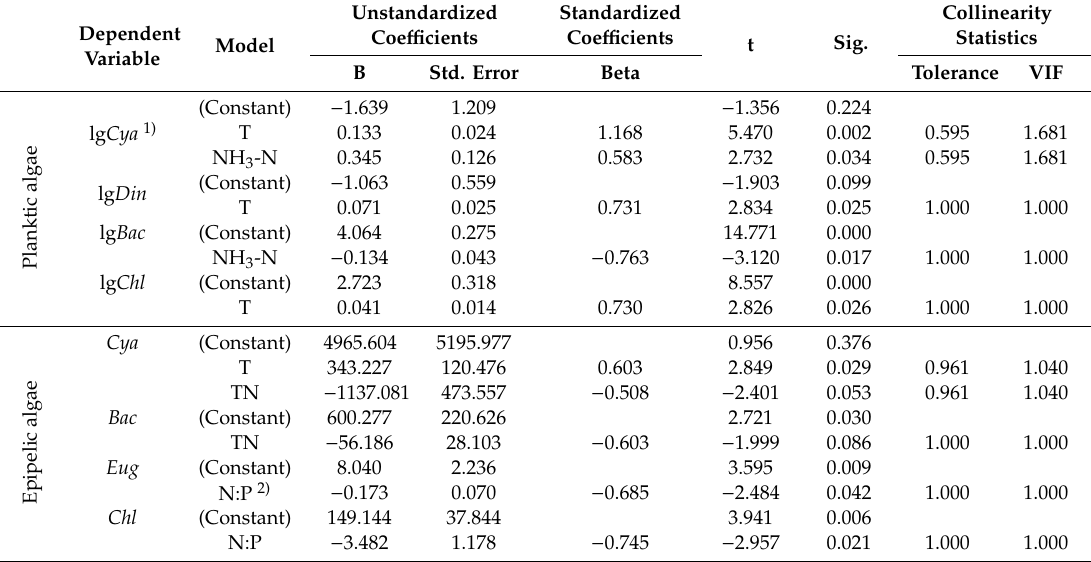
Table 6. Coe ffi cients ( n =